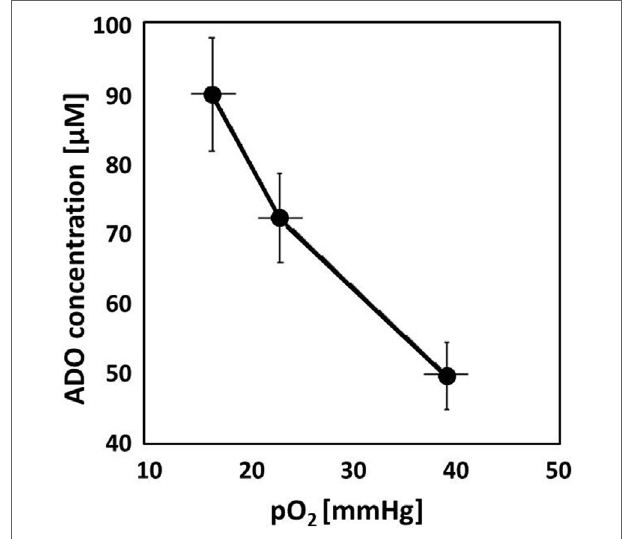
FiGURe 1 | Adenosine (ADO) concentration measured in experimental tumors (DS-sarcomas, n = 26) as a function of the tissue oxygenation status. With decreasing mean tumor pO 2 values, ADO accumulates in the tumor reaching ~100 µM in severely hypoxic tumors. For comparison, ADO levels in normal tissues are in the range of 10–100 nM (16, 17).